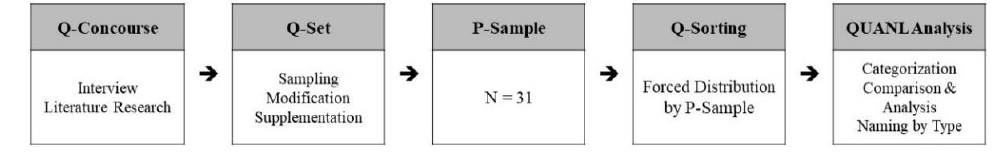
Figure 1. Research